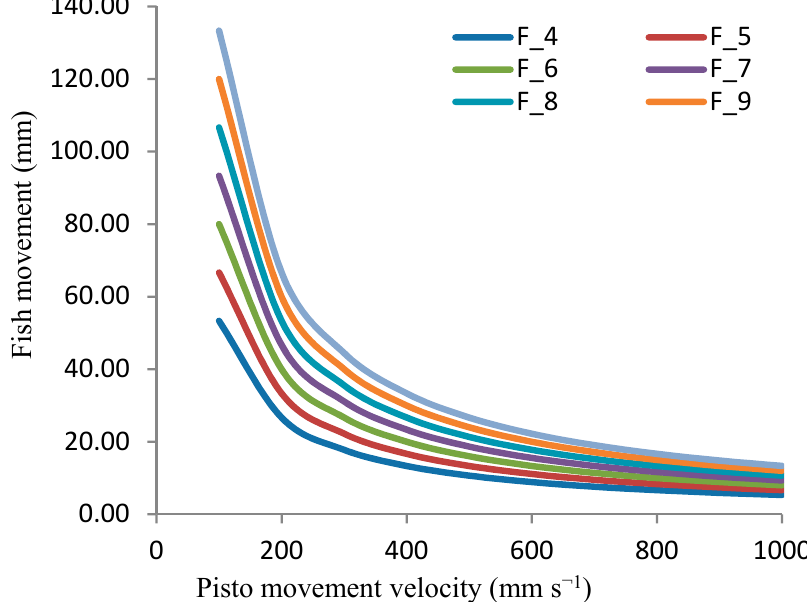
Figure 16. Fish movement at different jack speeds.